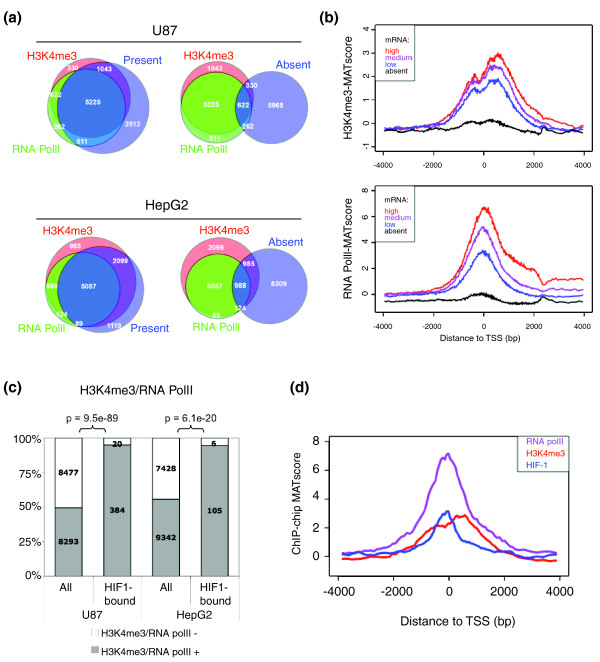
Determinants of HIF-1 binding. (a) H3K4 me3 modification and RNA Pol II binding at promoters are highly correlated with basal mRNA expression (present call). Proportional Venn diagrams of H3K4 me3 mark, RNA Pol II binding, and present calls in normal growth conditions in U87 and HepG2 cells. (b) mRNA expression levels are positively correlated with both H3K4 me3 and RNA Pol II binding intensities. All genes were separated into groups based on mRNA expression levels. Probe level intensities for H3K4 me3 and RNA Pol II were plotted as the aggregated mean of all genes in each group relative to the TSS. (c) Approximately half of all genes are marked with H3K4 me3 or the presence of RNA Pol II under normal growth conditions (All). Nearly all loci bound by HIF-1 (HIF1-bound) are marked by H3K4 me3 or RNA Pol II. Statistical significance determined by Fisher exact test. (d) Aggregate probe level intensities for H3K4 me3 (red), RNA Pol II (purple), and HIF-1 (blue) for all HIF-1 bound promoters are plotted relative to the TSS.